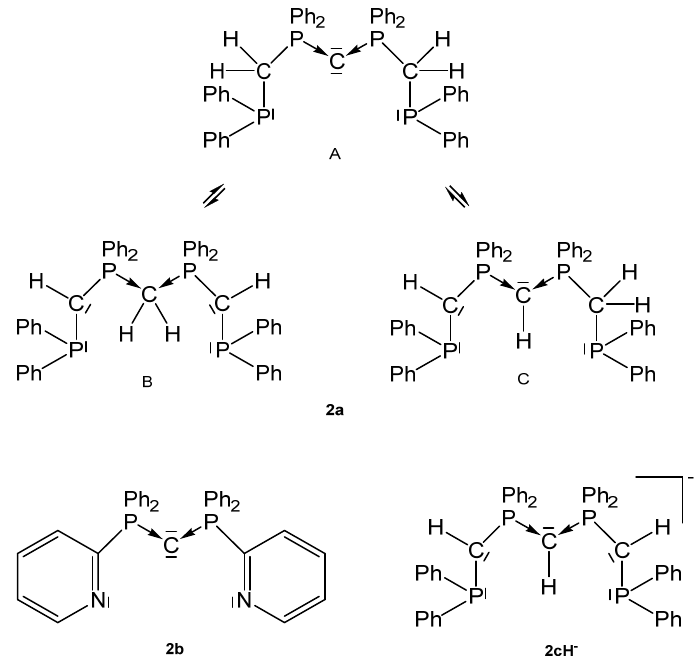
Figure 4. Tripodal basic pincer ligand 2a with its tautomers, the anionic pincer ligand 2cH − and the pyridyl pincer ligand 2b . Table 2. Transition metal complexes with the phosphine based pincer ligands 2a and the pyridyl based pincer ligand 2b ; C-M and P-C distances are included and 31 P NMR shifts in ppm.